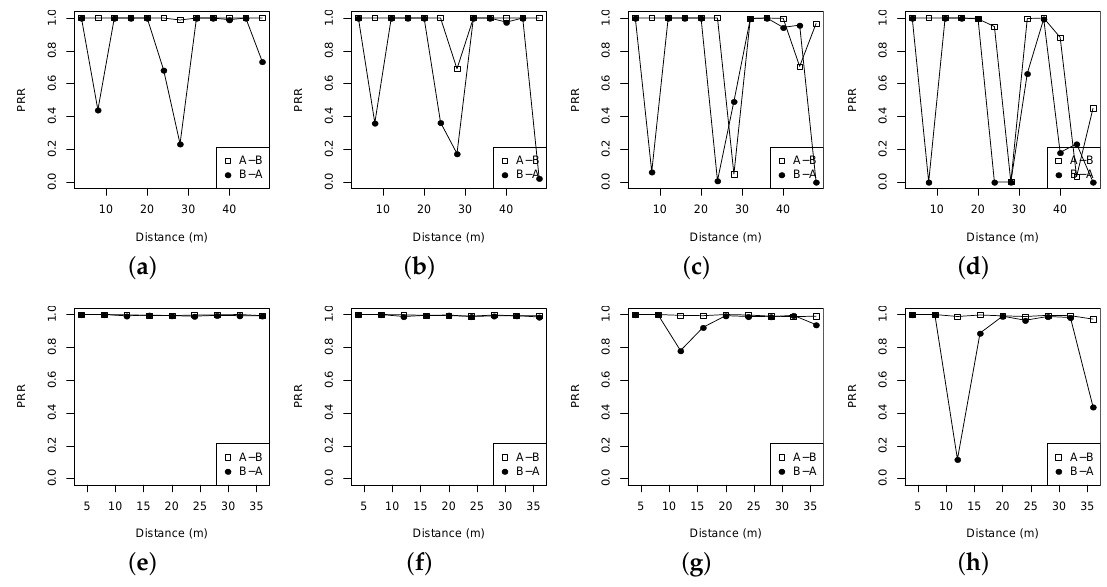
Figure 4. Packet reception ratio (PRR) distributions vs. distances with different transmit powers under two different forests. ( a ) Bajia, tx = 31; ( b ) Bajia, tx = 27; ( c ) Bajia, tx = 19; ( d ) Bajia, tx = 15; ( e ) Campus, tx = 31; ( f ) Campus, tx = 27; ( g ) Campus, tx = 19; ( h ) Campus, tx =